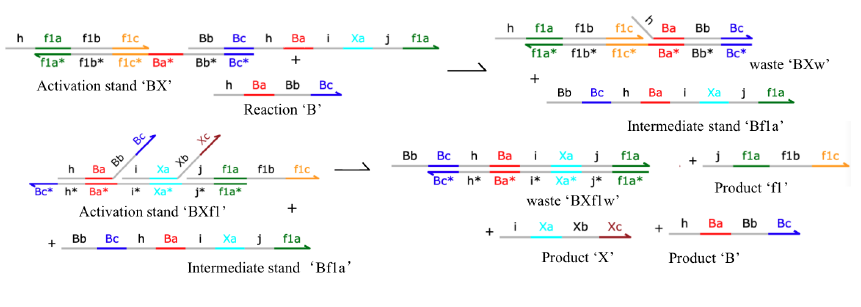
Figure 3. A list of the DNA reactions in B → B + X . The DNA domain of the color part is assumed to represent a unique DNA sequence. It is assumed that a domain can be bound to its complement, but cannot interact with any other domain in the system. It is also a part that can branch and